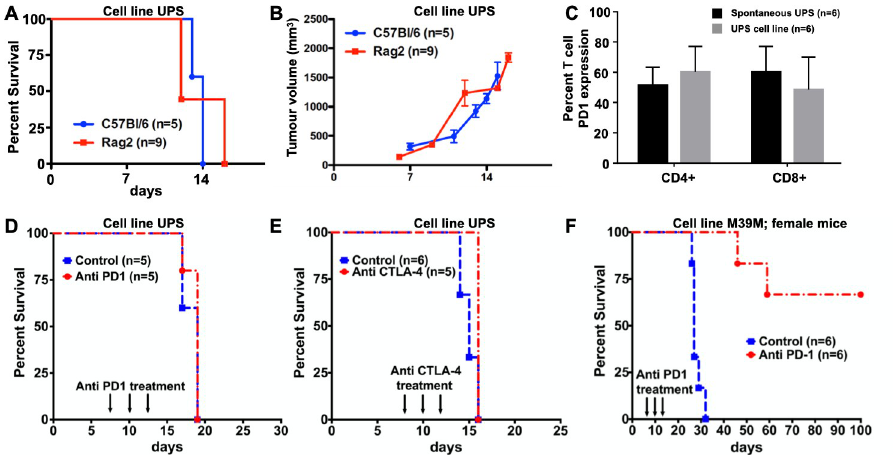
Fig 5. Murine UPS tumour growth is unaffected by lymphocyte deficiency and resistant to immunological checkpoint blockade therapy. (A-B) Survival and growth kinetics of UPS cells engrafted into lymphocyte deficient Rag2 KO mice were no different from control C57Bl/6 mice. (C) Despite 45–55% of CD4 and CD8 TILs expressing PD1, UPS bearing mice were resistant to anti-PD1 and anti-CTLA-4 therapy, whereas survival was 66% in the inflamed M3-9-M model similarly treated with anti-PD1